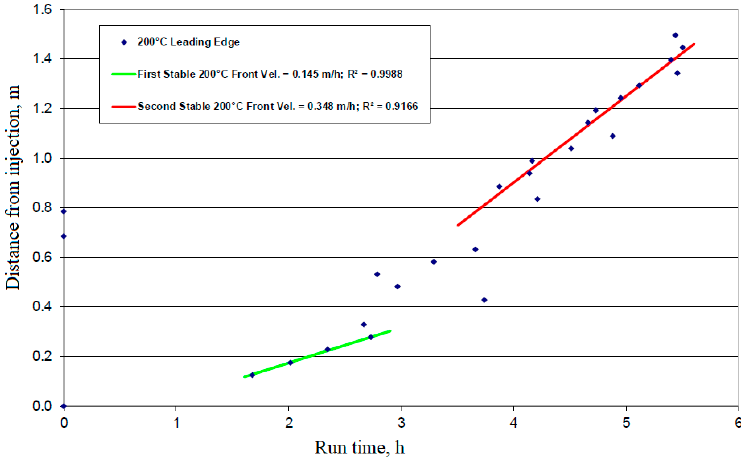
Figure 8. Reverse Combustion Front Locations (Color should be used).